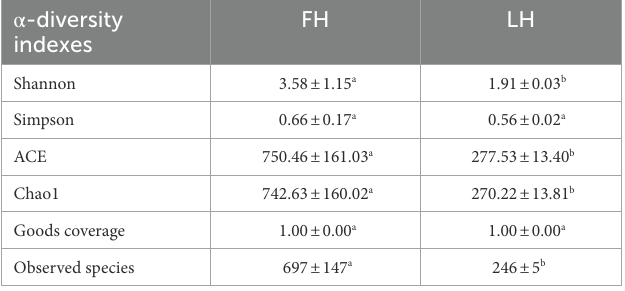
TABLE 4 α -diversity indexes of fungal communities in Jinhua FH and